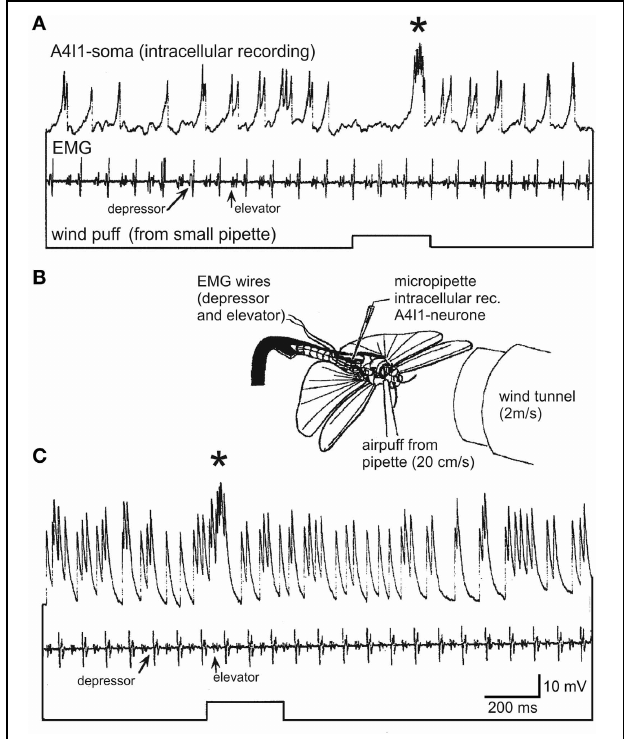
FIGURE 3 | Intracellular recording from the soma of an A4I1-interneuron (top trace), electromyogram from wing muscles (depressor and elevator, second trace), and wind puff monitor (bottom trace). The wind puff was applied to the side of the animal where the recorded A4I1 had its axon (i.e., ipsilateral to the axon, and thus contralateral to the soma). (B) Experimental situation (details in text). The locust was fixed to a holder and flying upside-down, and a small window was cut into the abdomen to expose the fourth abdominal ganglion which was immobilized on a small steel platform to avoid movement. 50 µ m steel wires insulated except for cut end were used for electromyograms and placed into respective muscles. The locust was flying spontaneously and without head wind from the wind tunnel in (A) ; the wind tunnel was switched on in (C)